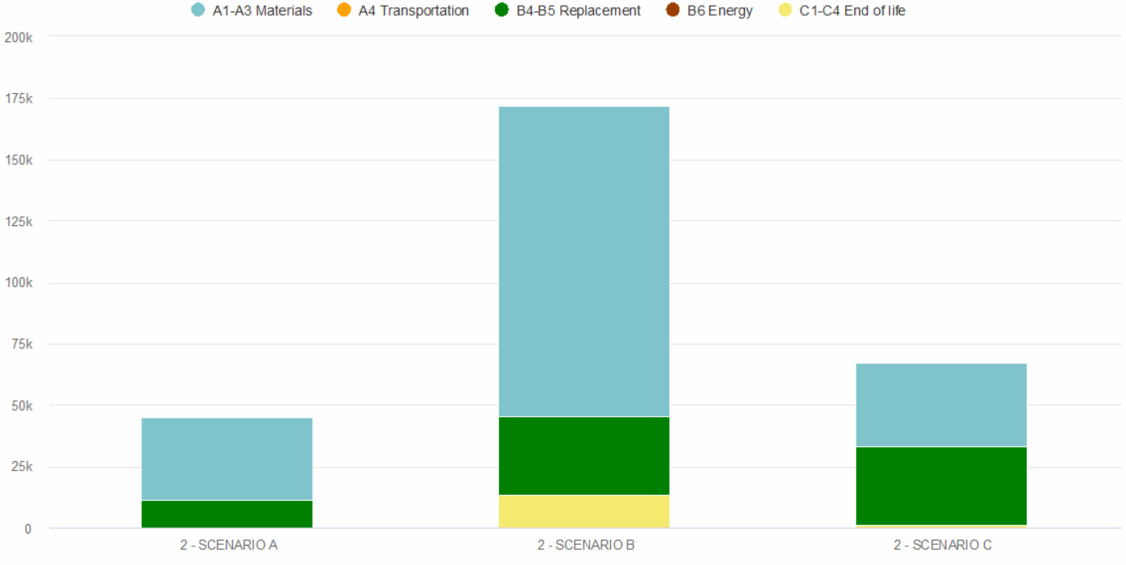
Figure 12. Global warming kg CO 2 -life cycle carbon. All impact categories of the three